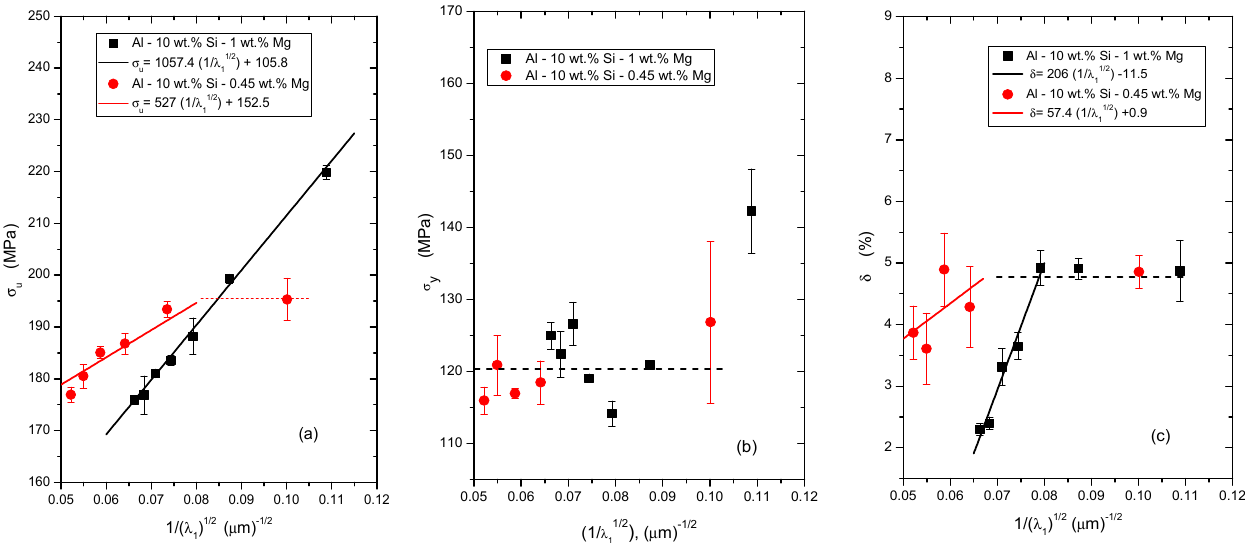
Figure 10. Tensile properties of the Al-10 wt.% Si-1 wt.% Mg and Al-10 wt.% Si-0.45 wt.% Mg alloys as function of λ 1 : ( a ) σ u , ( b ) σ y , ( c ) δ .